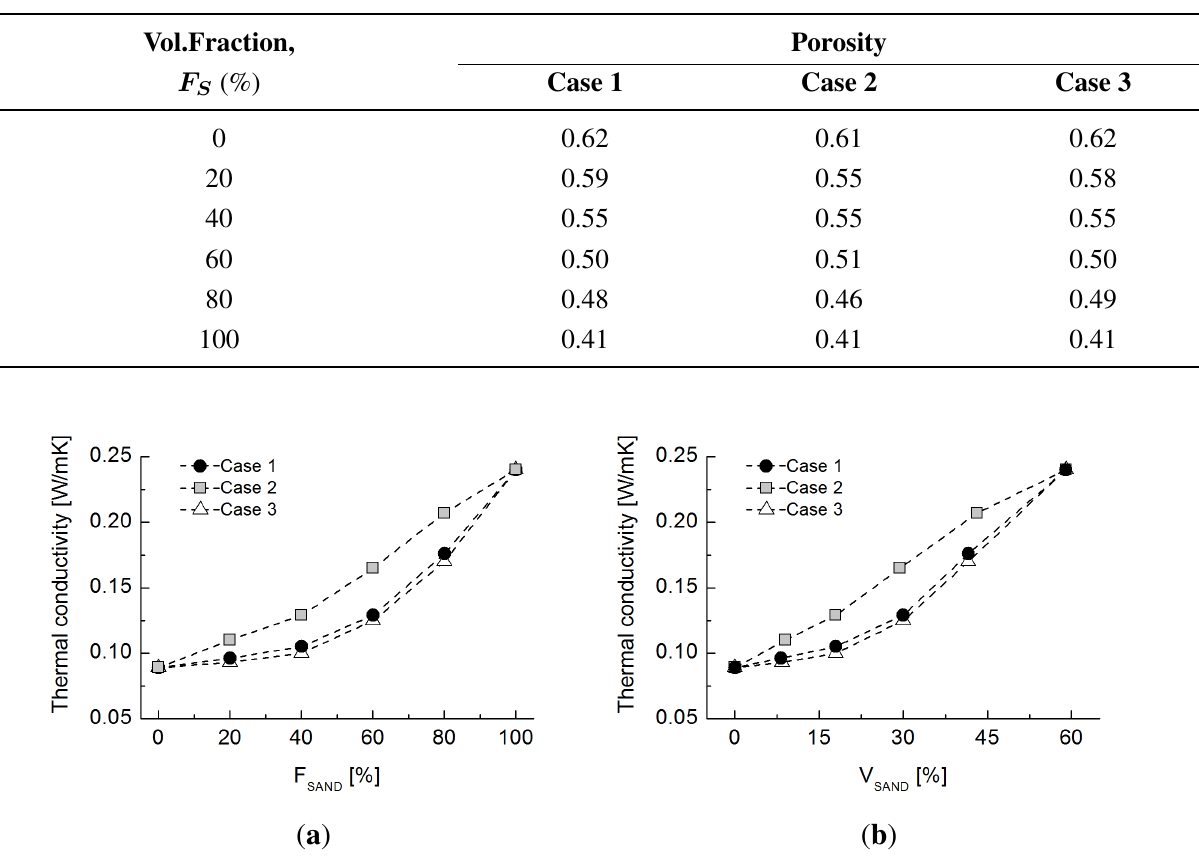
Figure 8. ( a ) Evolution of thermal conductivity values with varying volumetric fractions of sand for Cases 1 to 3; ( b ) density values with varying volumetric fractions of sand for Cases 1 to